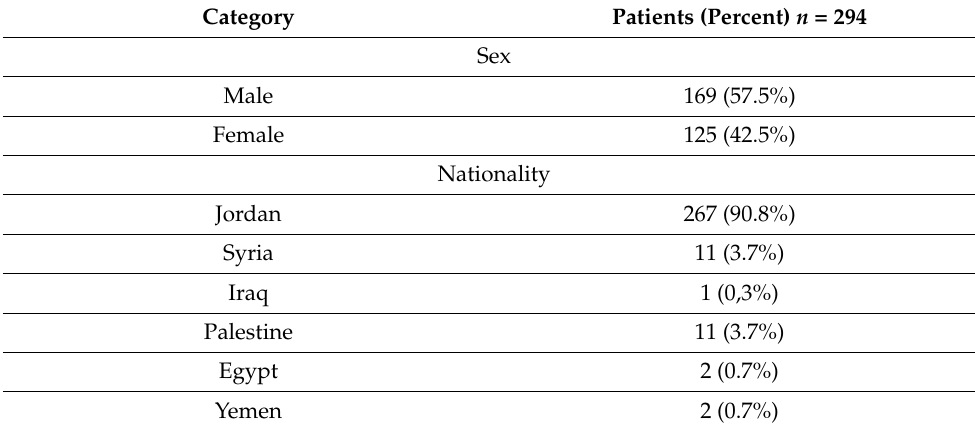
Table 1. Characteristics and clinical manifestations of PKU